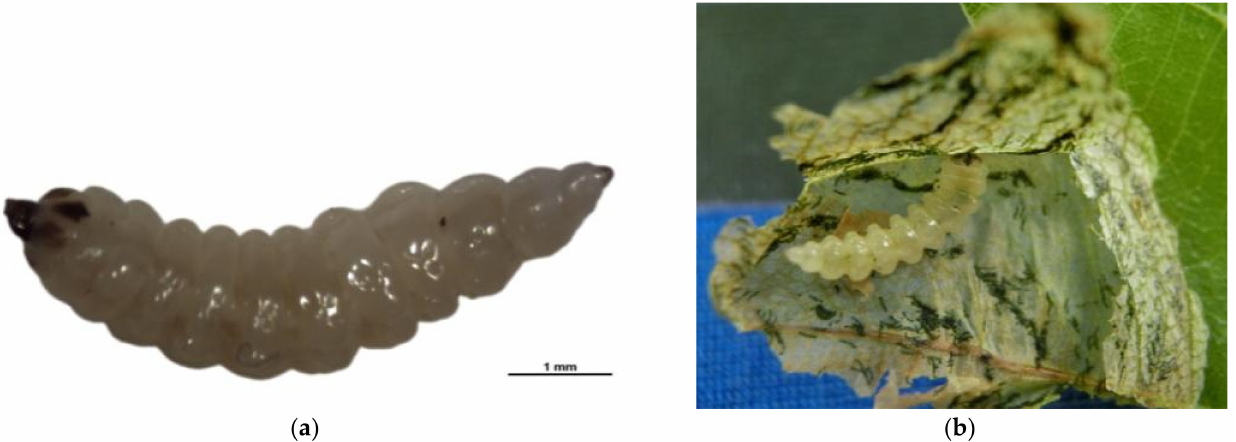
Figure 2. Larva of Rhynchaenus maculosus . ( a ) Photograph taken in laboratory; ( b ) photograph taken in blister-like chamber on oak leaf. Both ( a ) and ( b ) show a creamy-white, legless body without setae, the sharply defined segments, highly sclerotized mouthparts, and less sclerotized prognathous head.